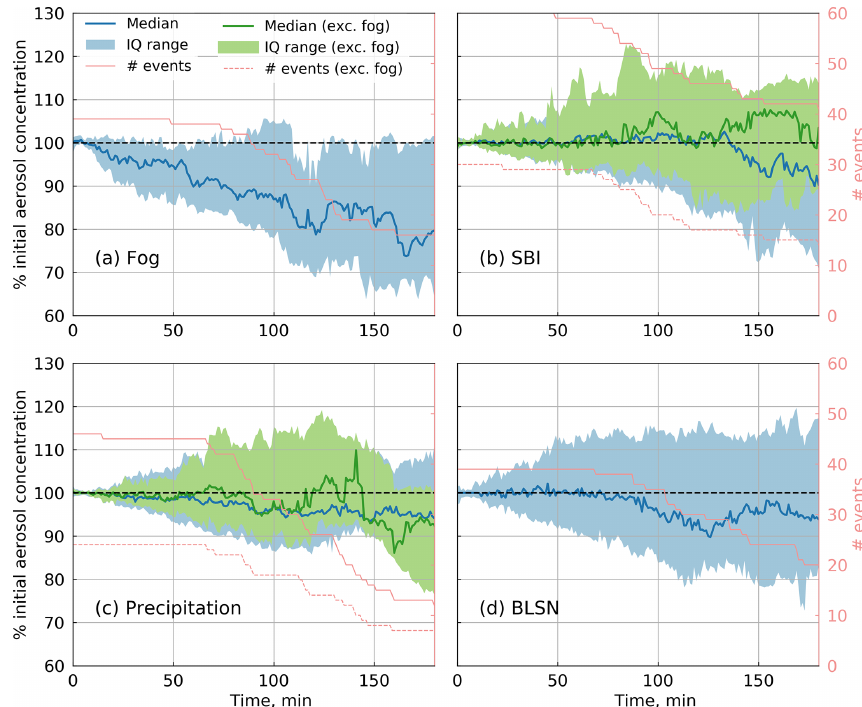
Figure 6. The change in surface aerosol particle concentration (%) over time during the first 3h of each event for (a) fog, (b) surface-based temperature inversions, (c) precipitation, and (d) blowing snow events. The thick blue line and blue shading are the median and interquartile range of all events; the thick green line and green shading are the median and interquartile range for SBI and precipitation events that do not contain fog. The pink line indicates the total number of events at each time step for all events (solid) and excluding fog events (dashed).